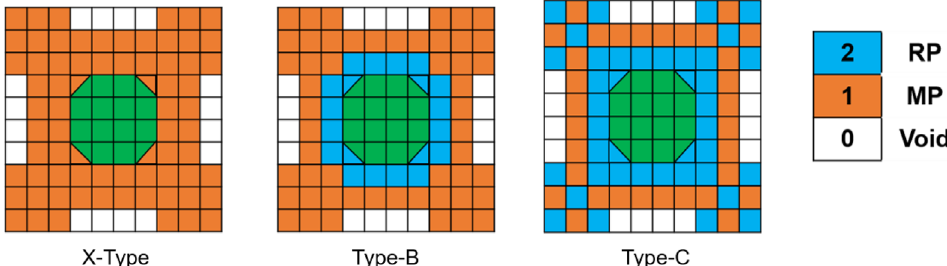
Fig. 1. The representative volume element (RVE) of the multifunctional structural battery system by digital design of constituting phase patterns of mechanical metamaterials: (a) Initial X-Type inspired from literature [14]. (b, c) Types-B and C with dual-phase lattices. Note that matrix phase (MP) are termed as phase 1, reinforcement phase (RP) as phase 2, and defect/void phase as